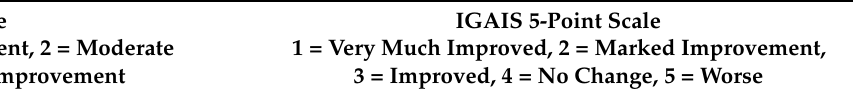
Table 4. Investigator Global Aesthetic Improvement Scale (IGAIS). IGIAS 4-point scale, IGIAS 5-point scale and pooled scores are presented that combine the 4 and 5 point